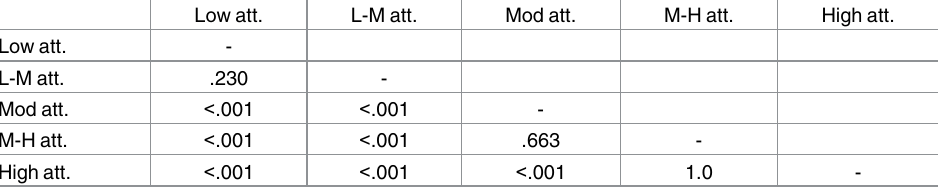
Table 1. Results of Dunn’s multiple comparison test with Bonferroni correction for the grade distribu- tions of different attendance groups. The table containscorrected p -valuesfor each pairwisecomparison, corresponding to the null hypothesisthat the pair of groups has equal